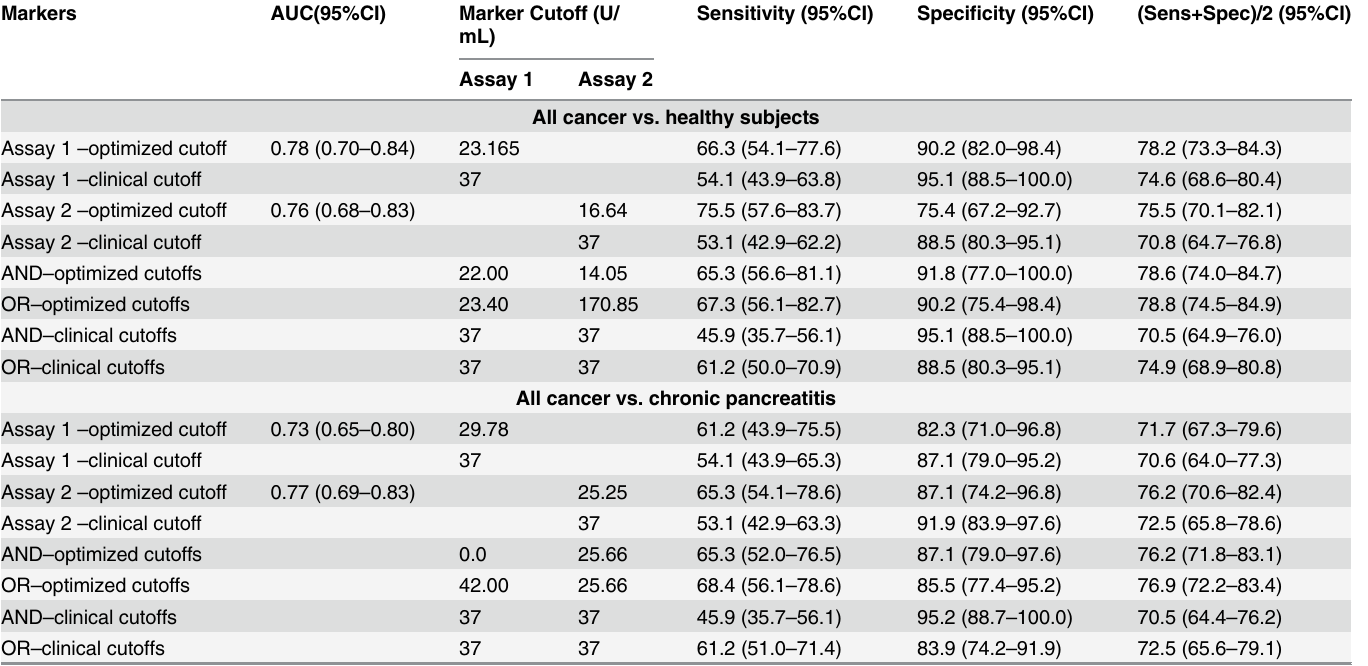
Table 2. Marker performance at selected